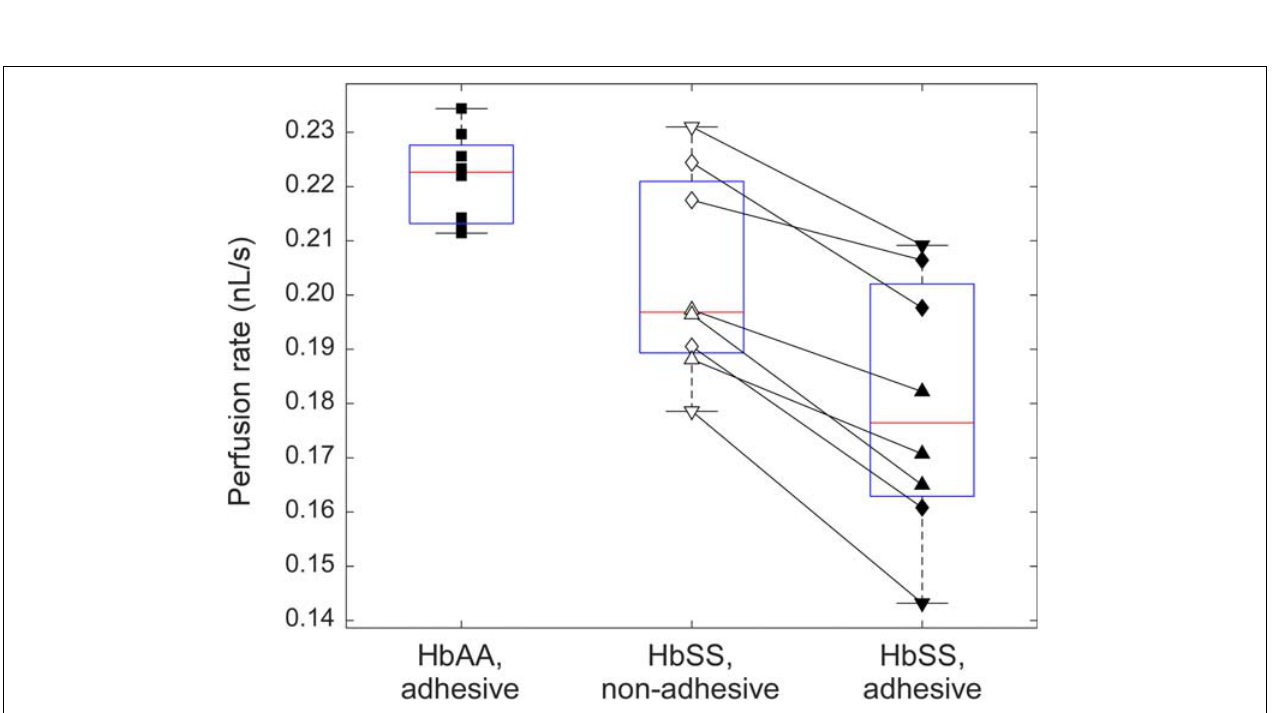
FIGURE 3 | A box-plot comparison between the perfusion rates in adhesive (LN) and non-adhesive (mPEG) networks of the AMVN device for samples of normal (HbAA, n = 8) and sickle (HbSS, n = 8) RBCs suspended at 25% HCT. HbAA samples are indicated by squares. For samples from SCD patients (HbSS), triangles denote treatment with hydroxyurea, upside down triangles denote treatment with transfusion therapy, and rhombi denote treatment with both hydroxyurea and transfusion. All differences between the groups are statistically significant ( p < 0.05).